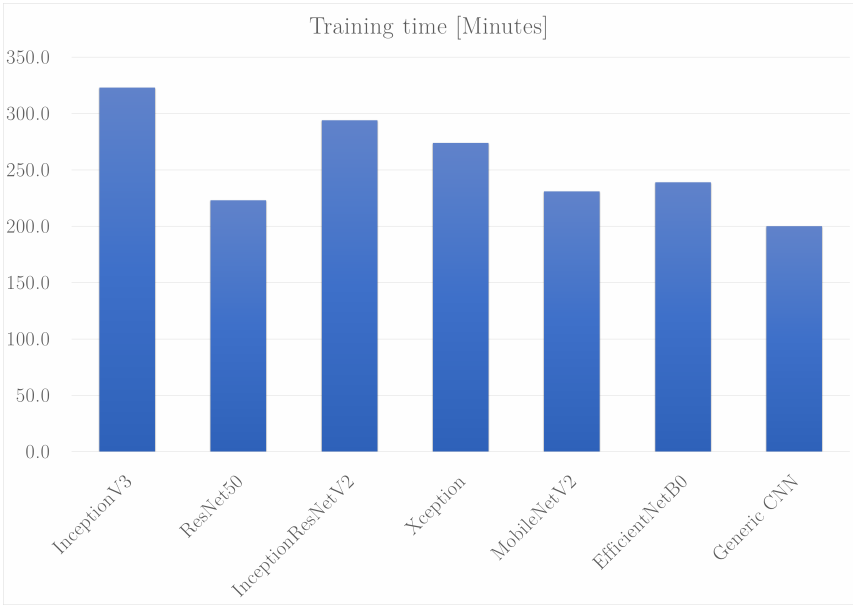
Figure 16. Training time (in minutes) of every model in this